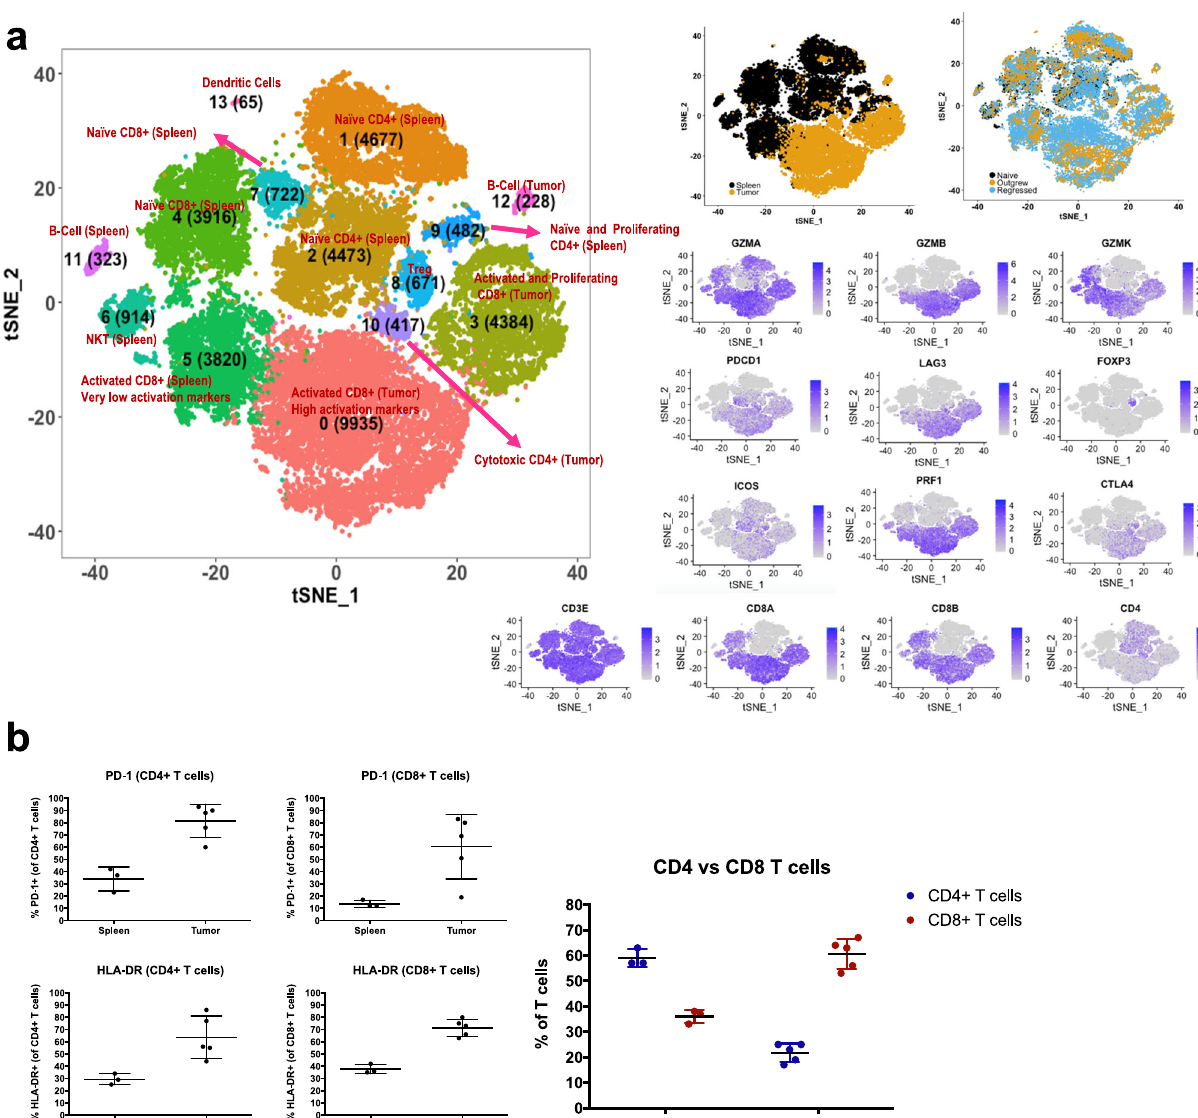
Fig. 4 Characterization of tumor-in fi ltrating T cells from regressing Raji tumors. a Human immune system (HIS) reconstituted mice were challenged with Raji ( n = 13). The spleens and tumors were harvested from regressors and processed for FACS sorting of total hCD45 + /hCD3 + T cells. Tumor- derived and splenic T cells were analyzed for VDJ and whole transcriptome using 10X genomics approach. The t-SNE plots show localization of spleen versus tumor, naive versus progression versus regression and highlights speci fi c activation markers. b The spleen and matching tumor were harvested from the Raji-challenged HIS-reconstituted mice ( n = 5) the same day tumor rejection was observed. Both splenic T cells and tumor T cells were stained with antibodies to look at HLA-DR/CD4 + T cells, HLA-DR/CD8 + T cells, and PD-1/CD4 + T cells and PD-1/CD8 + T cells. Mean value with SD are indicated. Error bars are equivalent